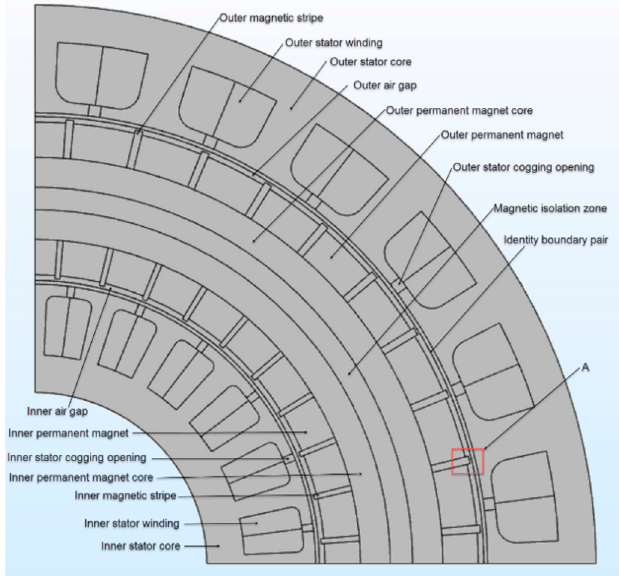
Figure 1. Structure of the PMSM with a magnetic stripe in the rotor.